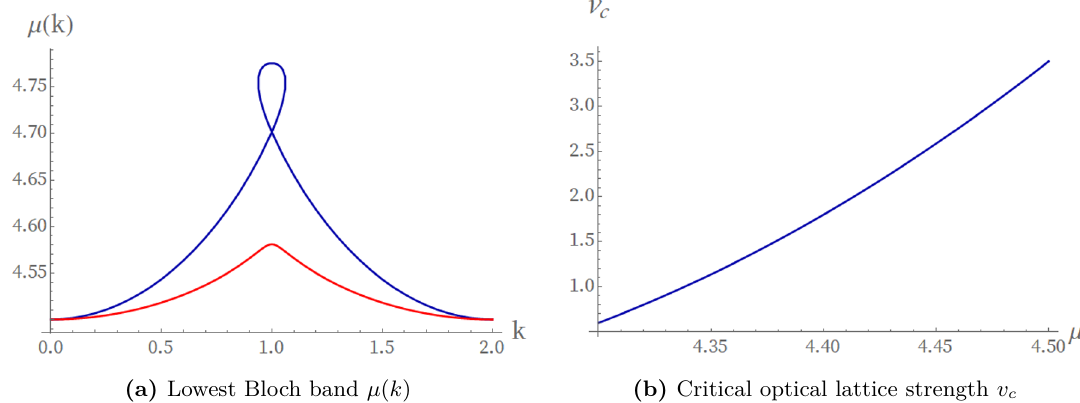
Figure 2. Figure 2a shows the lowest Bloch band µ ( k ) as a function of Bloch wave vector k with fixed total particle number N , whose value is given by the case of chemical potential µ = 4 . 5 , lattice strength v = 0 . 5 (blue), 4 (red) and Bloch wave vector k = 0 . Figure 2b shows the relation between critical optical lattice strength v c and chemical potential µ . The Bloch band will have loop structure when v < v c